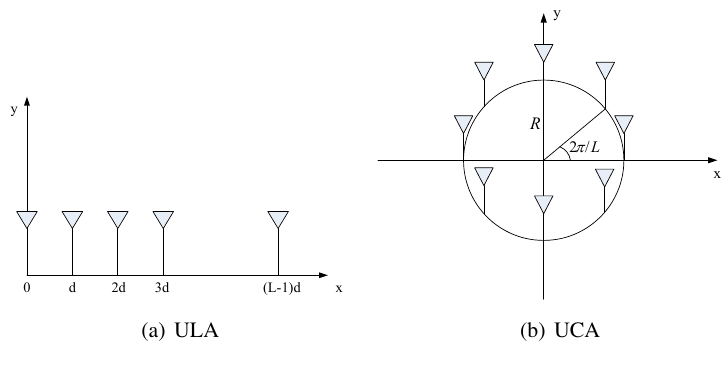
Figure 6. Array Figure 6. Array geometries